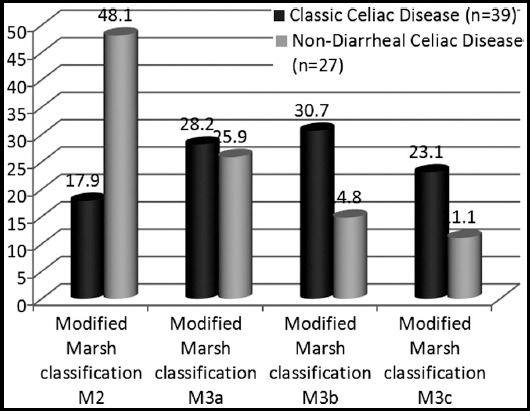
Patients distribution on Modified Marsh Classification Histopathology for Duodenal Biopsies.